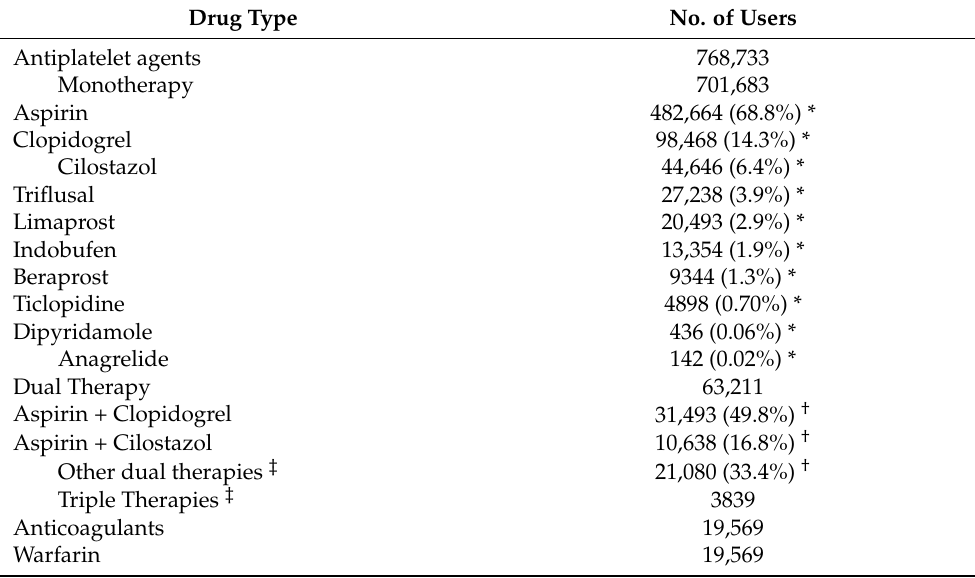
Table 1. Number of participants using antithrombotic